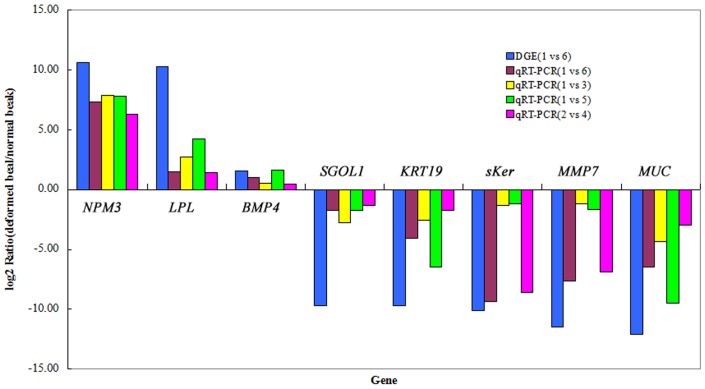
qRT-PCR of 8 transcripts for validating the DGE results.The horizontal axis identifies the 8 transcripts examined by qRT-PCR; the vertical axis shows the relative gene expression level in deformed (individuals 1 and 2) versus normal (individuals 3, 4, 5, and 6) beak tissues. The 4 pairs of individuals were all full sibs. The first bar shows the value obtained from DEG using 1 and 6. NPM3  =  nucleophosmin/nucleoplasmin 3; LPL  =  lipoprotein lipase; BMP4  =  bone morphogenetic protein 4; SGOL1  =  shugoshin-like 1; KRT19  =  Keratin 19; sKer  =  similar to Scale keratin; MMP7  =  matrix metalloproteinase 7; MUC  =  mucin protein.